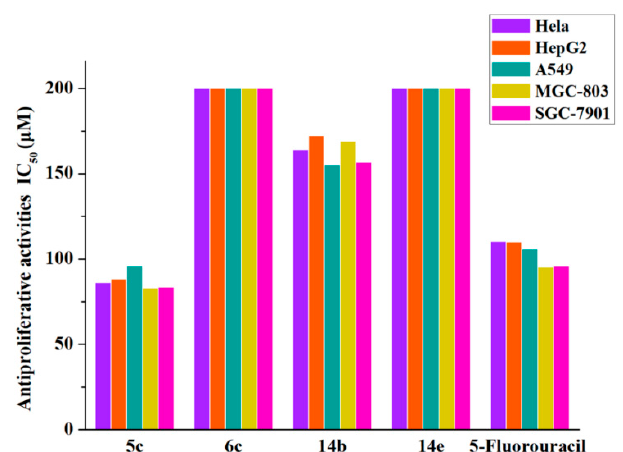
Figure 3. Antiproliferative activities of compounds 5c , 6c , 14b, and 14e against A549, HepG2, HeLa, MGC-803, and SGC-7901 cell lines. Table 1. IC 50 values ( μ M) of compounds 5c, 6c, 14b and 14e against cancer cell lines. Compound